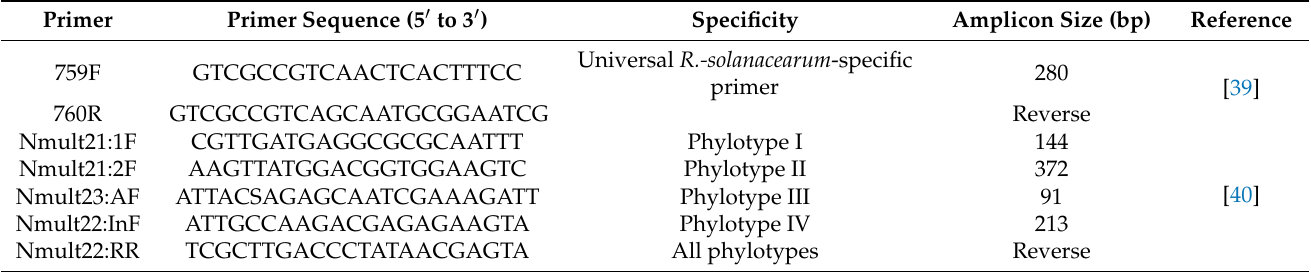
Table 2. List of primers used for multiplex